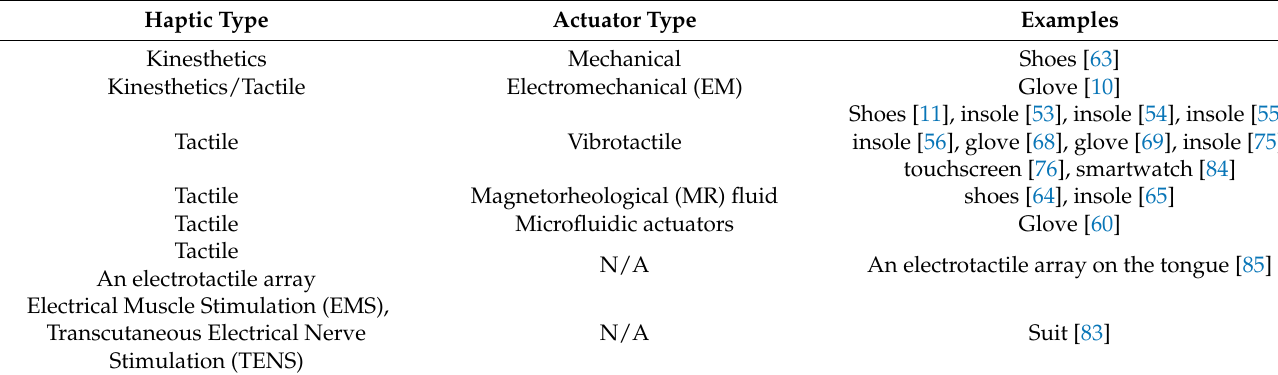
Table 2. The main types of actuators used.